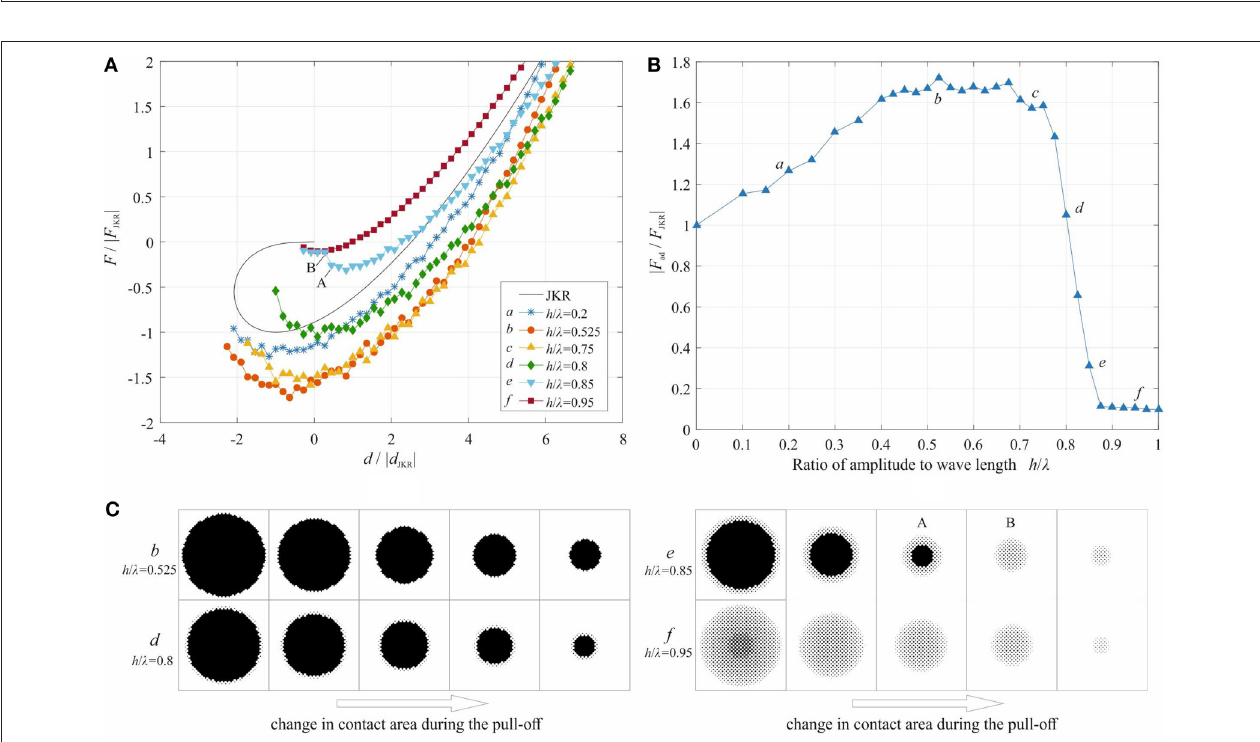
FIGURE 4 | Adhesive contact of a rough sphere. (A) Load-displacement dependence for different amplitudes of waviness; (B) dependence of adhesive force on the amplitude of the waviness; (C) four exemplary evolutions of the contact area during